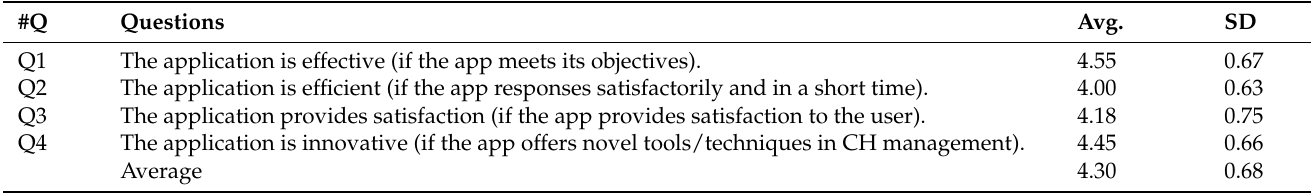
Table 9. Questions concerning the perceived performance of the ARtful mobile